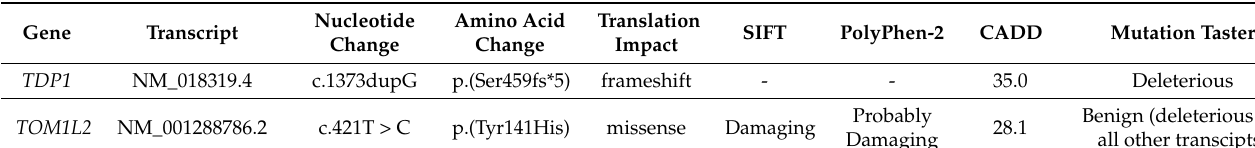
Table 2. Variants of interest. TDP1 and TOM1L2 are located on chromosomes 14 and 17, respectively. Predictions by SIFT [32], PolyPhen-2 [33], and CADD score were obtained from the IVA software. Prediction by Mutation Taster was obtained from Mutation Taster2021 [34].